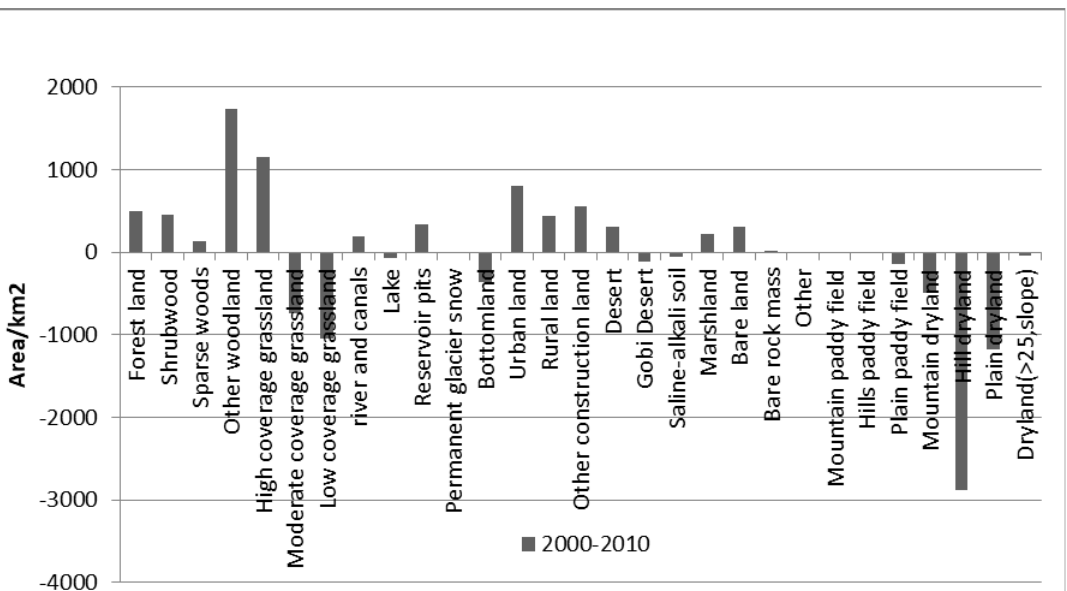
Figure 4. Land use structure changes from 2000 to 2010.